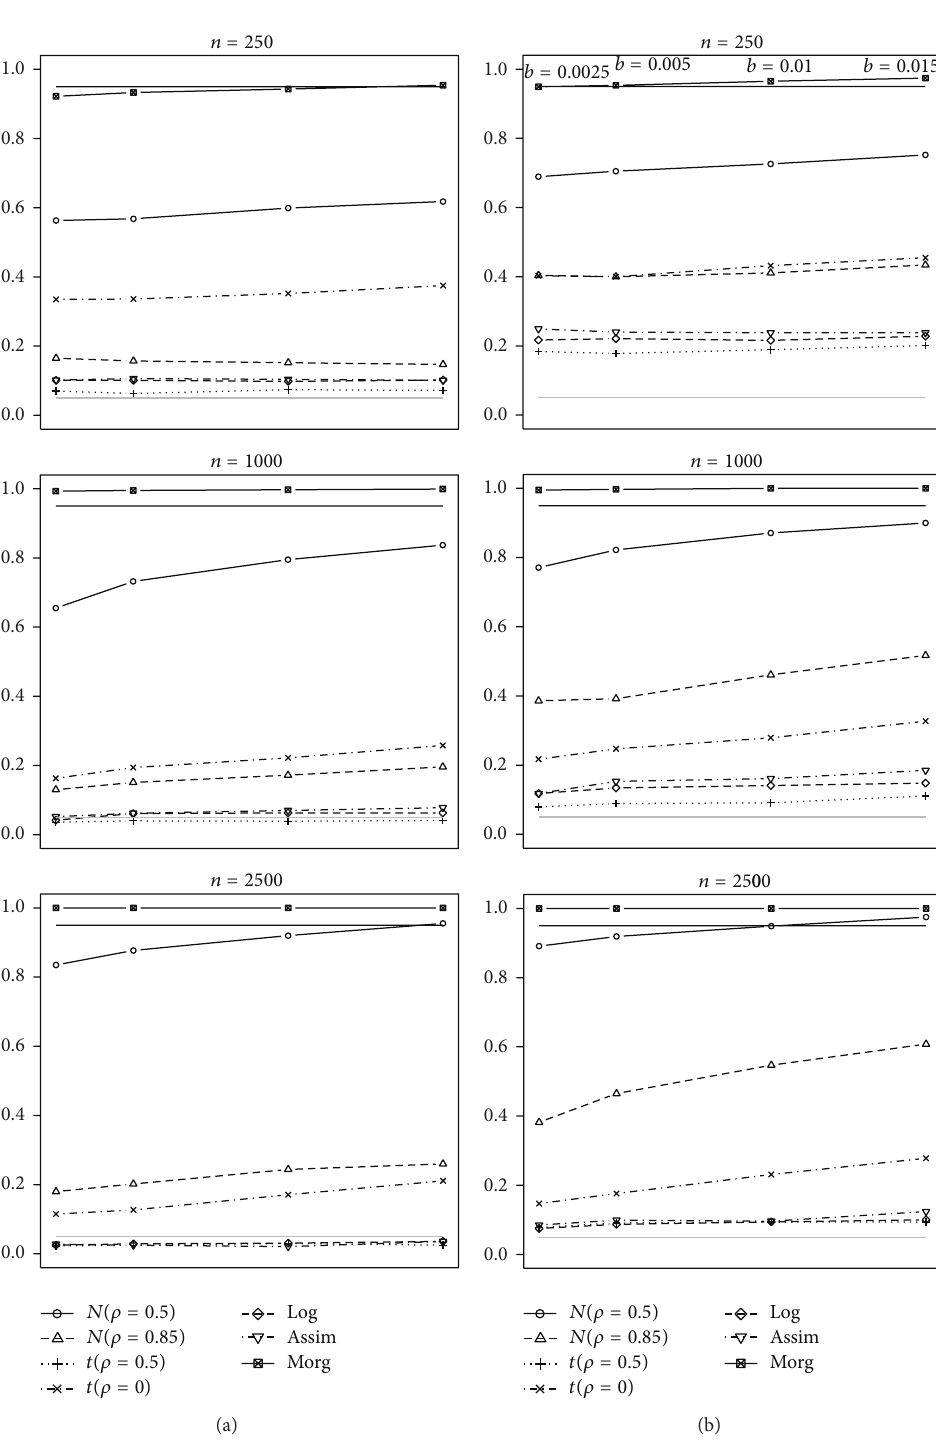
Figure 6: Proportion of samples in which 𝜂 = 1 is rejected by a 5% test for test 1 (a) and for test 2 (b). The horizontal solid lines correspond to 95% confidence (black) and 5% significance (grey). The four values plotted in each line correspond to 𝑏 = 0.0025, 0.005, 0.01, 0.015 ,